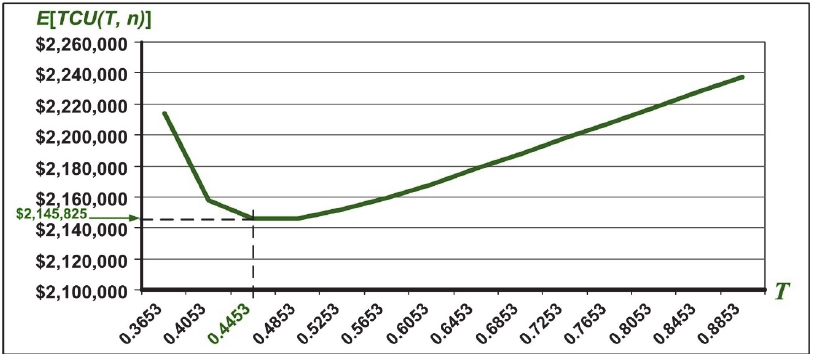
Fig. 6. Variations in cycle length T effects on E[ TCU ( T, n